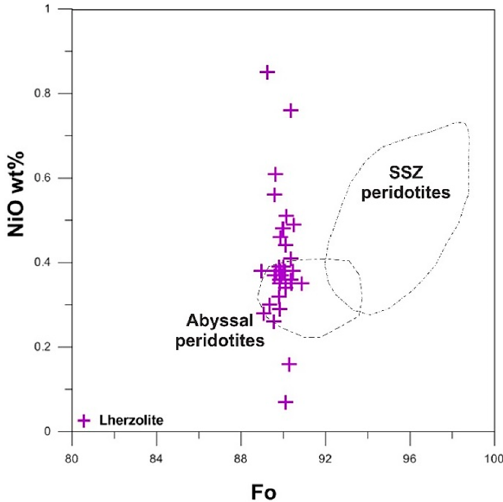
Figure 7. Compositional variations of olivines from the Edessa lherzolite in a Fo vs. NiO diagram. Abyssal and supra-subduction zone (SSZ) fields from Sobolev et al. [46] and Ishii et al. [47], respectively.